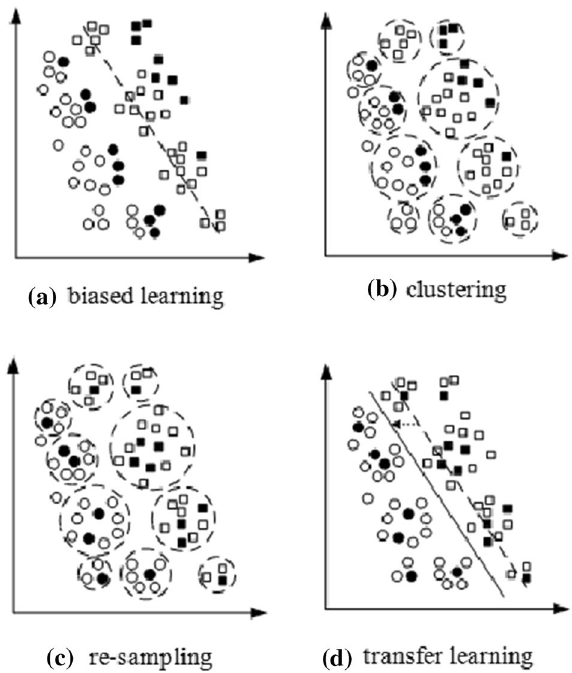
Brief analysis of sample selection; Kernel mean matching